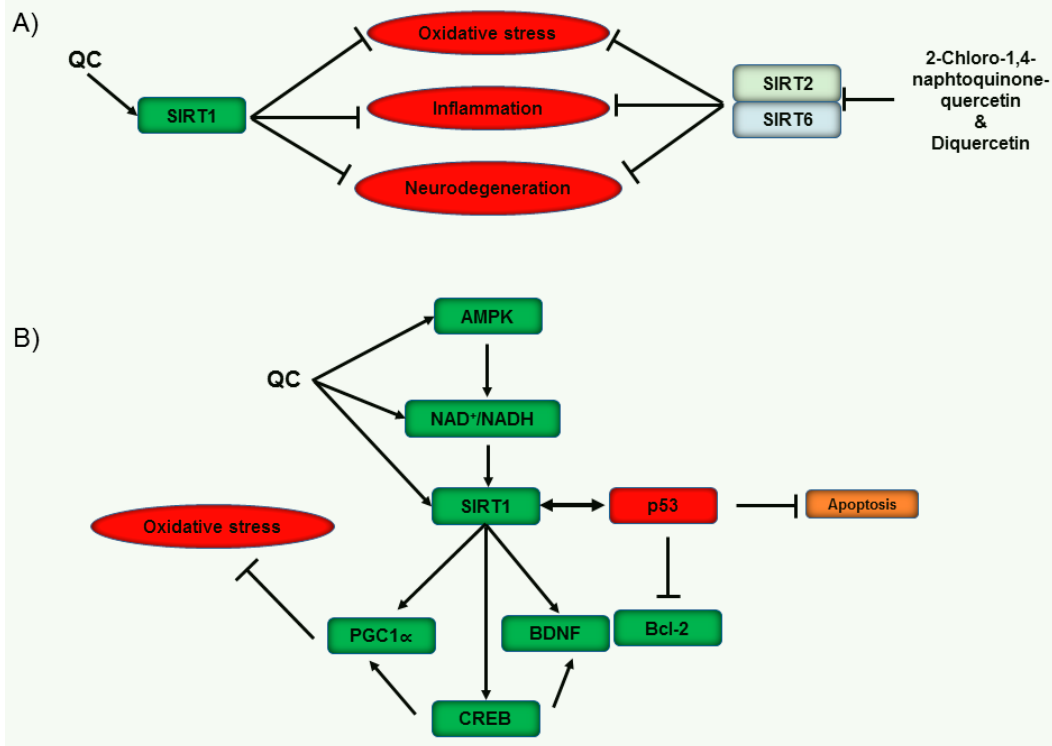
Figure 5. QC-mediated regulation of sirtuins for the therapy of cognitive impairment. The action of QC on several sirtuin proteins, leads to protective action. ( A ) QC-mediated activation of SIRT1 and 2-chloro-1,4-naphtoquinone-quercetin- and diquercetin-mediated prevention may have potential in the prevention of oxidative stress, inflammation and neurodegeneration. ( B ) QC-mediated stimulation of SIRT1 and regulation of AMPK and NAD +/ NADH may have potential against oxidative stress and apoptosis. QC: Quercetin; SIRT: Sirtuin; AMPK: AMP-activated protein kinase; NAD: nicotinamide adenine dinucleotide; BDNF: Brain-derived neurotrophic factor; Bcl-2: B-cell lymphoma 2; CREB: Cyclic AMP response element binding